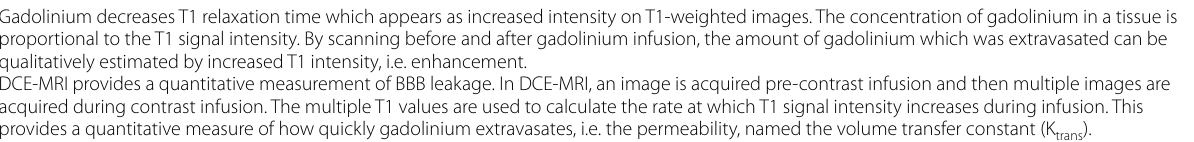
Table 4 Assumptions of gadolinium-contrast MRI